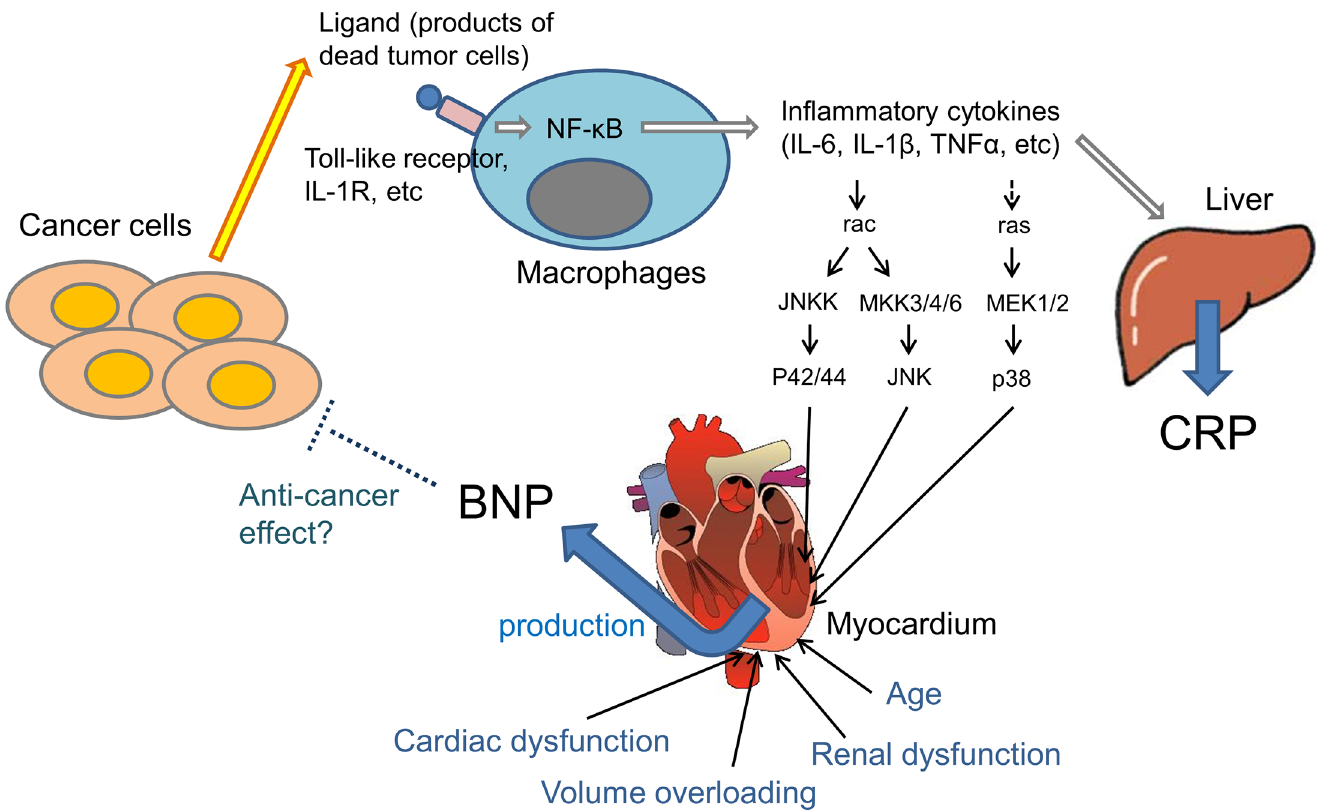
Fig 7. Hypothesized relationship between cancer and the BNP level. In the tumor microenvironment, inflammatory cells, including macrophages, producevarious cytokines in responseto tumor cells and tissue necrosis. In cardiomyocytes, BNP synthesis has been shown to be upregulatedat the transcriptional level by inflammatory cytokines. Based on these previousfindings and our present study, we hypothesized that the production of BNP might be increasedin cancer patients by cancer-related inflammation independentof the cardiacfunction, renal function, and age.